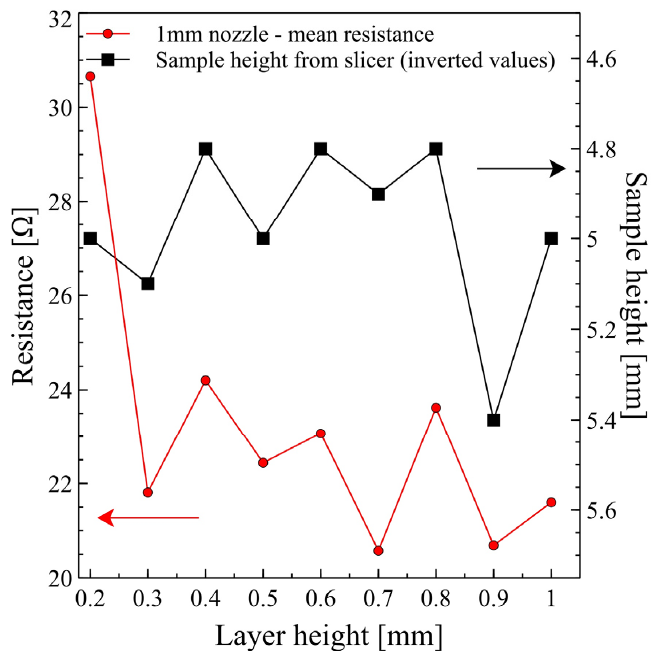
Figure 6. Mean resistance values for 1 mm nozzle printouts compared with sample height generated by slicer software—sample height plot intentionally inverted for better visualization of correlation.